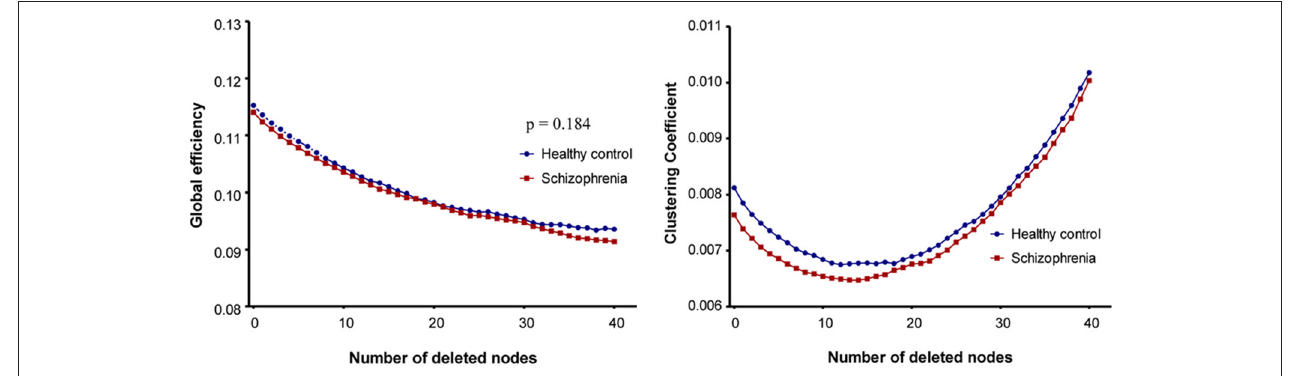
FIGURE 1 | Plots of robustness analysis in schizophrenia patients and healthy control subjects. In case of global efficiency, a linear mixed model was used to assess the group-by-number of removed nodes